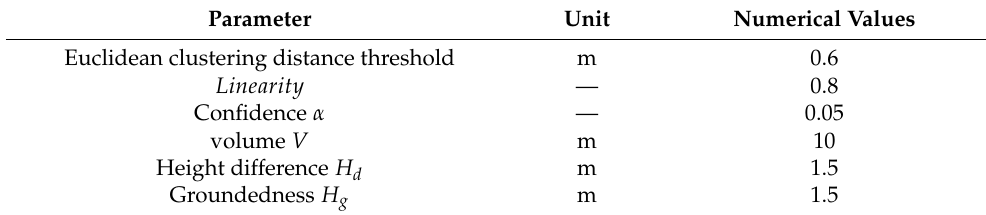
Table 3. Algorithm parameter threshold